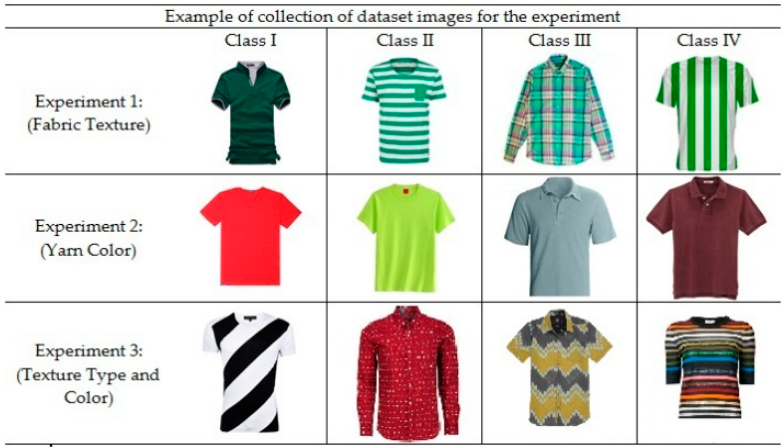
Figure 4. Illustration example of the custom-built dataset images with four classes for each test.